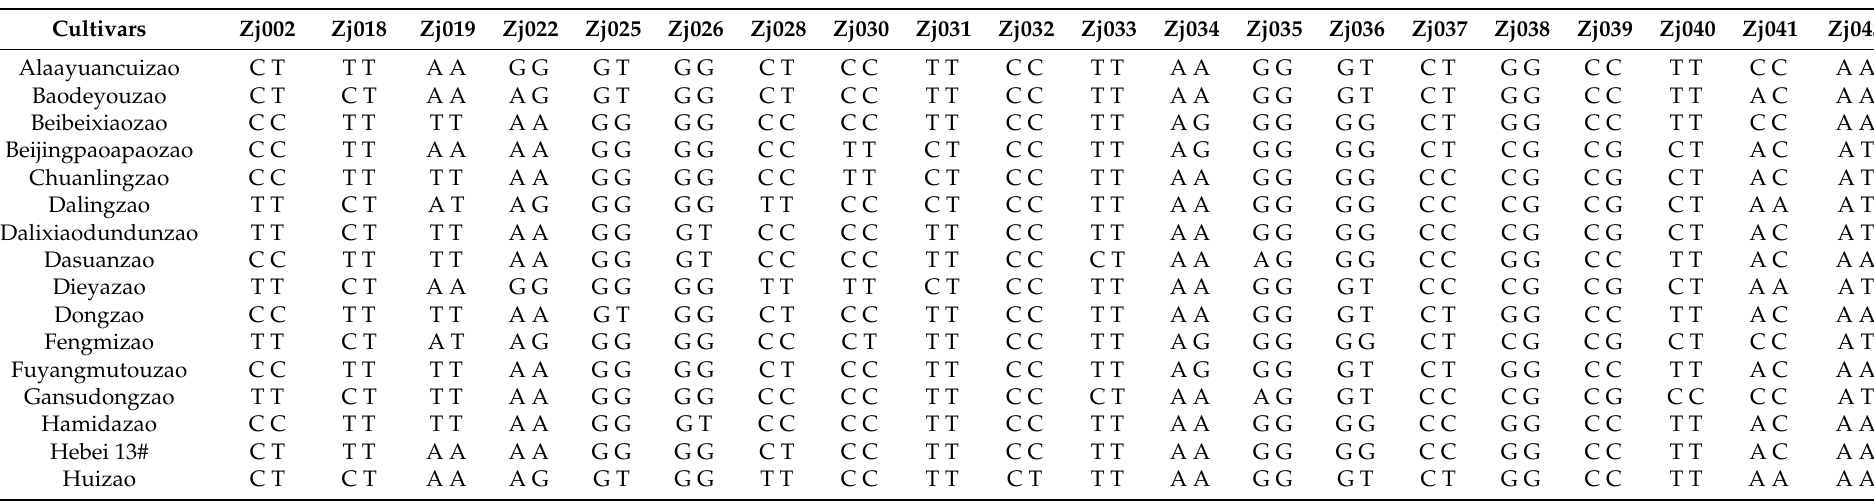
Table 2. Examples of DNA fingerprints based on the array of 192 SNPs for jujube cultivar identification (showing truncated